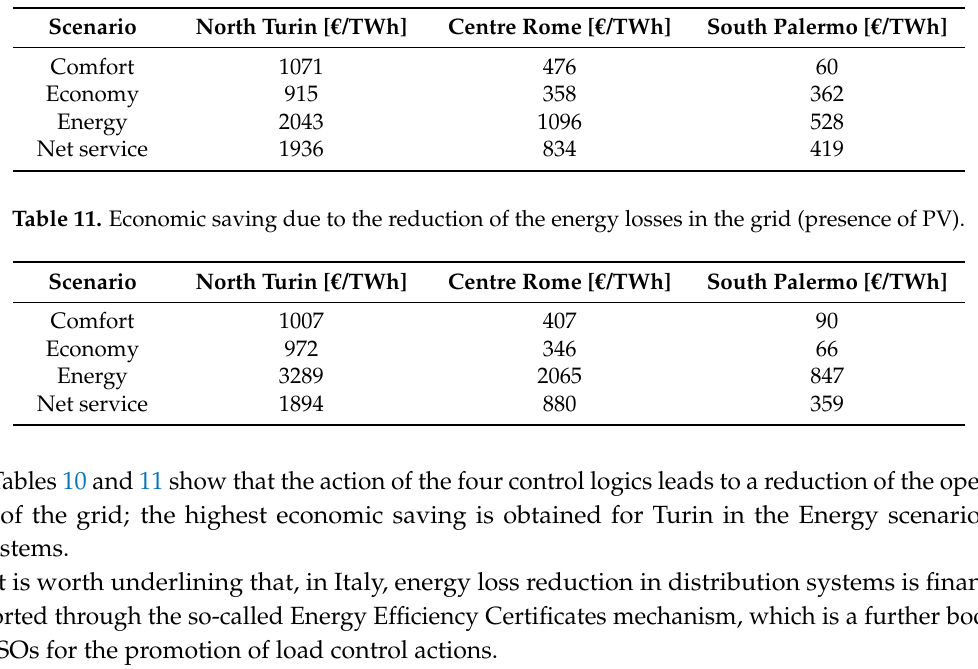
Table 10. Economic saving due to the reduction of the energy losses in the grid (No PV).